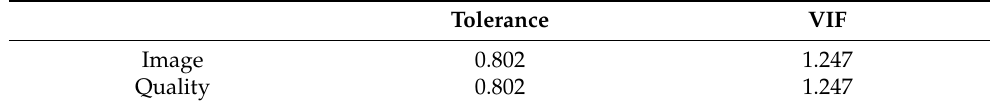
Table 4. Tolerance and Variance Inflation Factor (VIF)